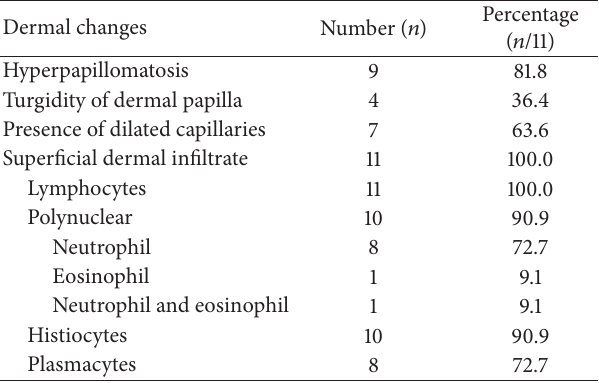
Table 2: Histological dermal changes in 11 severe psoriasis